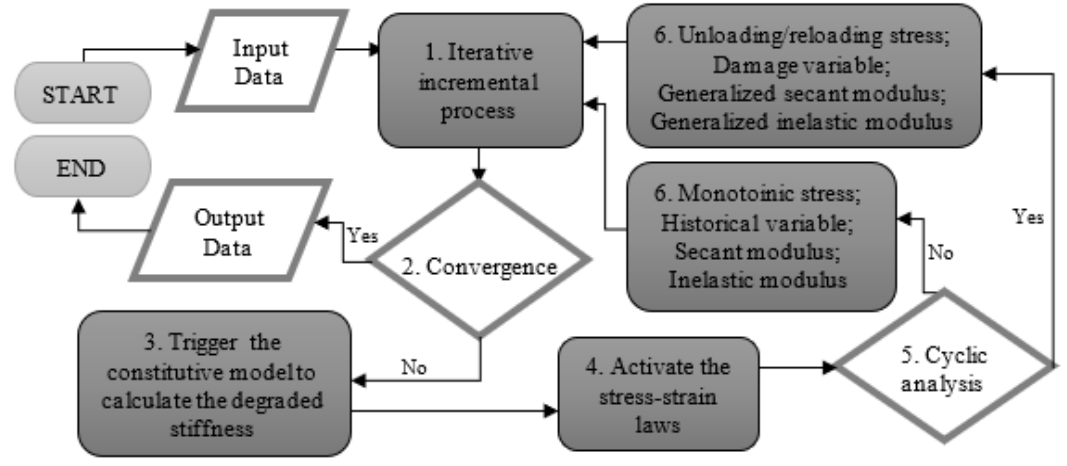
Figure 1. Cyclic analysis process.